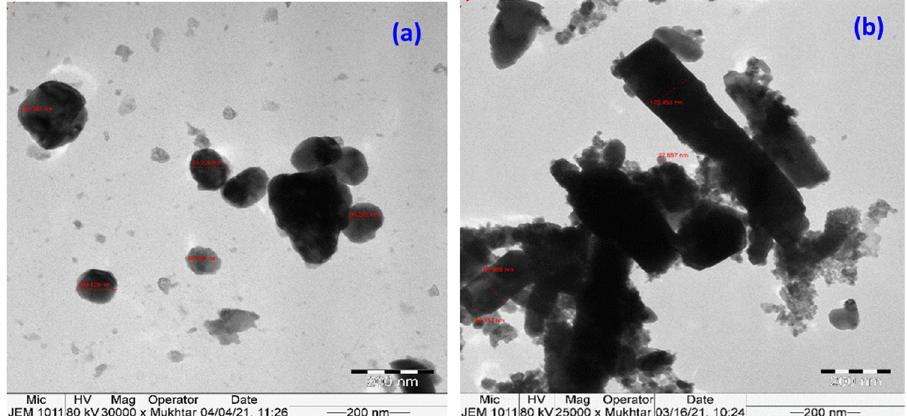
Figure 4: TEM micrographs of: ( a ) undoped ZnO and ( b ) ZnO - Fe -